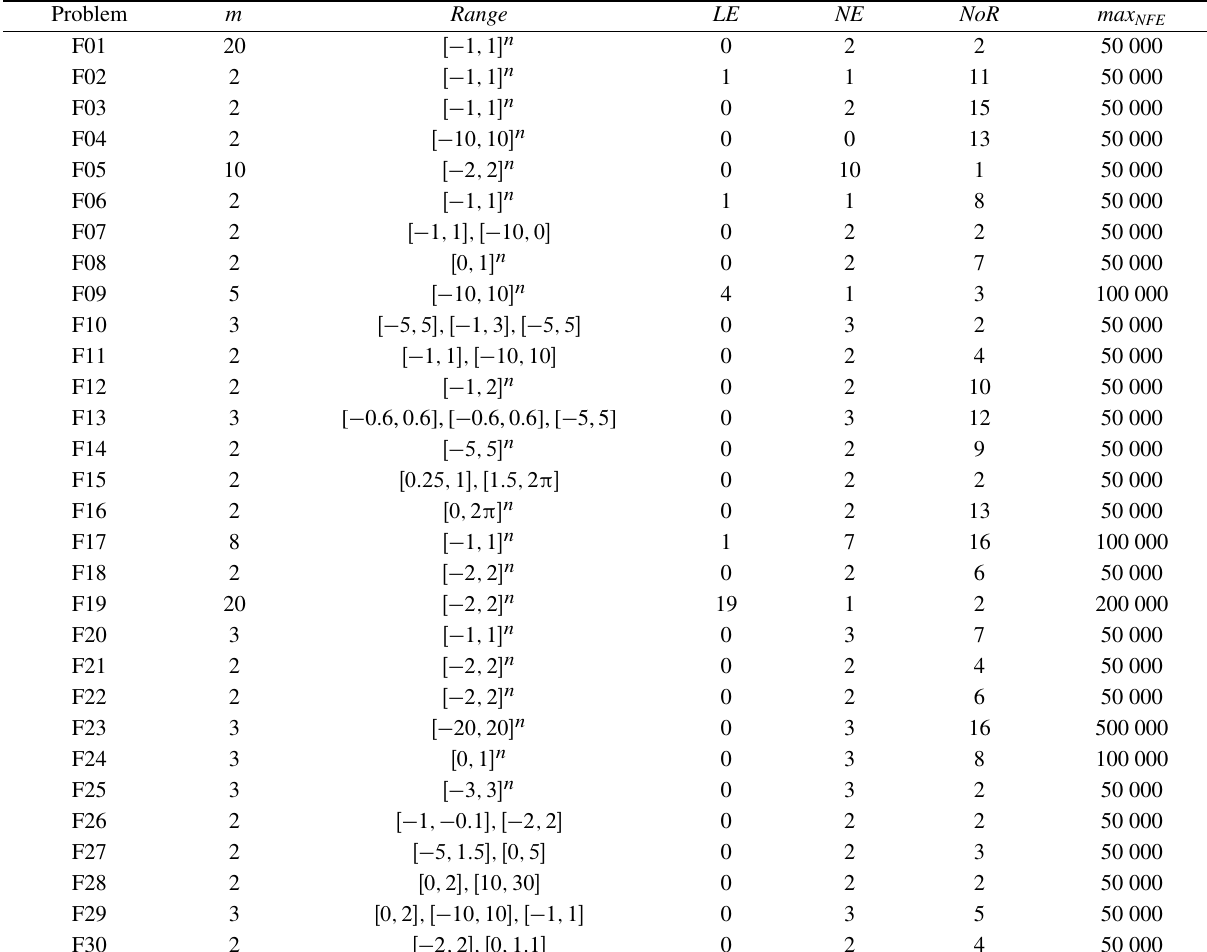
Table 2 Brief information of the test